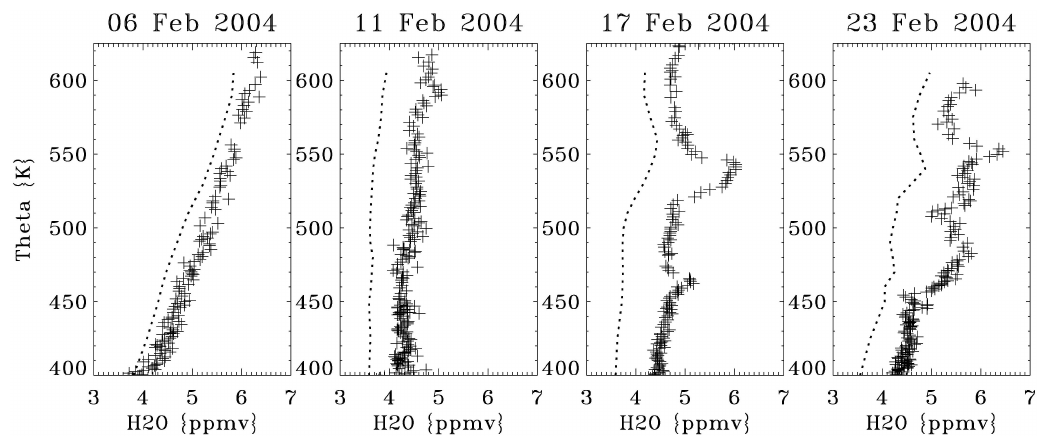
Fig. 4. Profiles of water vapour on 06, 11, 17, and 23 February 2004 as measured by FLASH (black crosses), as well as from ECMWF analyses advected with MIMOSA (black